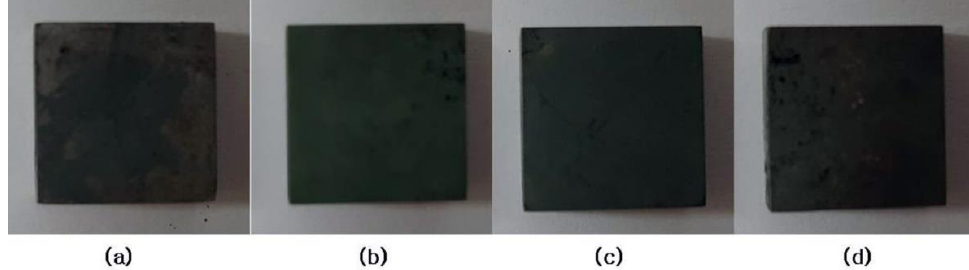
Figure 6. Appearance of Cr–xAl–5%Si alloy surfaces after the isothermal heating: ( a ) 0% Al; ( b ) 5% Al; ( c ) 10% Al; and ( d ) 20% Al.